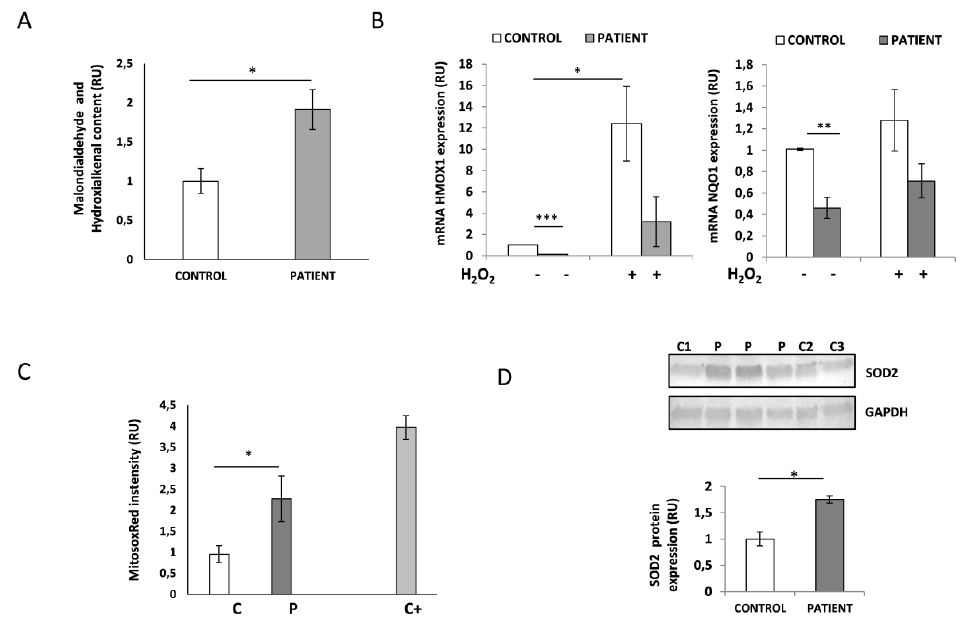
Figure 5. Analysis of oxidative stress in HACE1 patient fibroblasts. ( A ) The quantification of malondialdehyde and hydroxialkenal levels demonstrated higher levels of lipid peroxidation in HACE1 patient fibroblasts. P, patient; C1-C3, controls. * p < 0.05. ( B ) Quantitative PCR showed significantly decreased mRNA levels of HMOX1 and NQO1 at the basal state as well as upon oxidative stress induced by H 2 O 2 in HACE1 patient. Experiments were performed in triplicate and results are expressed in relative units (RU). Peptidylprolyl isomerase A ( PPIA ) was used as an internal control. * p < 0.05, ** p < 0.01, *** p < 0.001. ( C ) Mitochondrial superoxide anion levels were analyzed by MitoSOXRed staining and flow cytometry. Increased levels of MitoSOXRed fluorescence intensity were detected in HACE1 patient fibroblasts. Cells treated with antimycin A were used as positive control. Results are expressed in relative units (RU). Patient (P); control (C); positive control (C + ); * p < 0.05. ( D ) Western Blot analysis demonstrated higher levels of SOD2 protein expression in HACE1 patient fibroblasts. GAPDH was used as the loading control. Cell lysates from several controls (C) and four di ff erent extracts from the patient (P) were analyzed. * p <